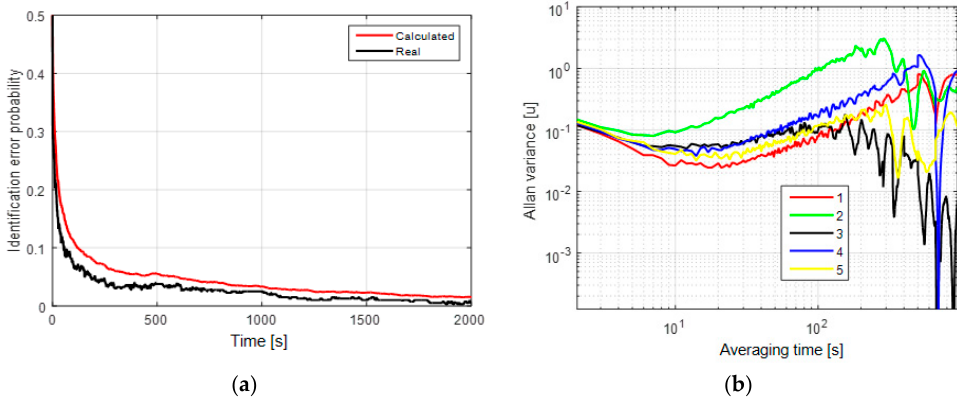
Figure 2. ( a ) Unconditional probability of the identification error with white-noise component of known RMS; ( b ) Allan variances for the sums of white noises with σ v = 0.5 u and the random walk with = 0.04 u (1—red), σ = 0.15 u (2—blue) and with the first-order Markovian process with τ = 1 min, σ w w = 0.5 u (3—black), τ = 5 min, σ = 1 u (4—blue), and τ = 25 min, σ = 1.5 u σ m m m